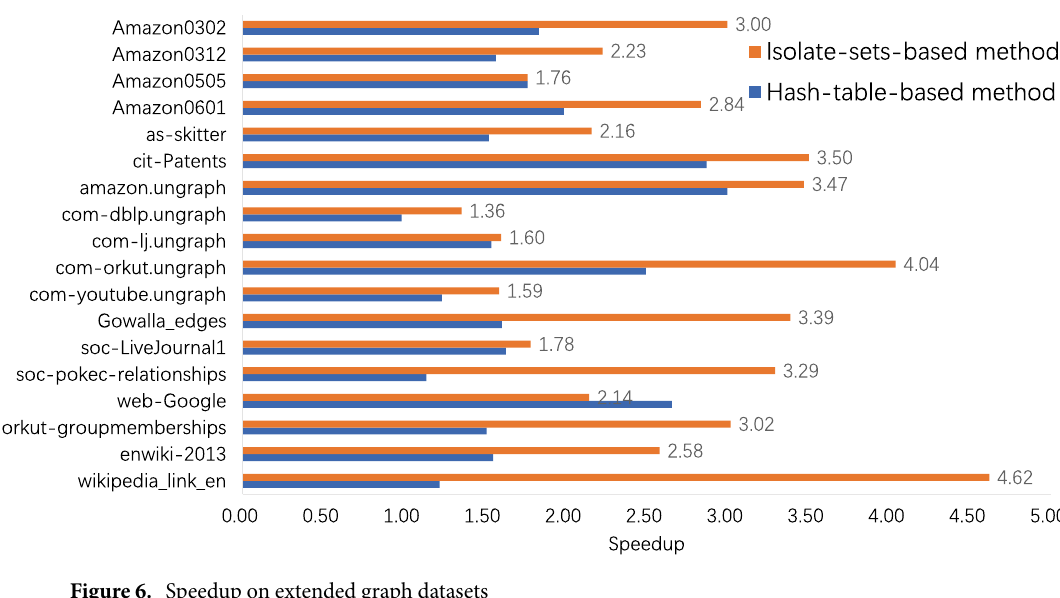
Figure 6. Speedup on extended graph